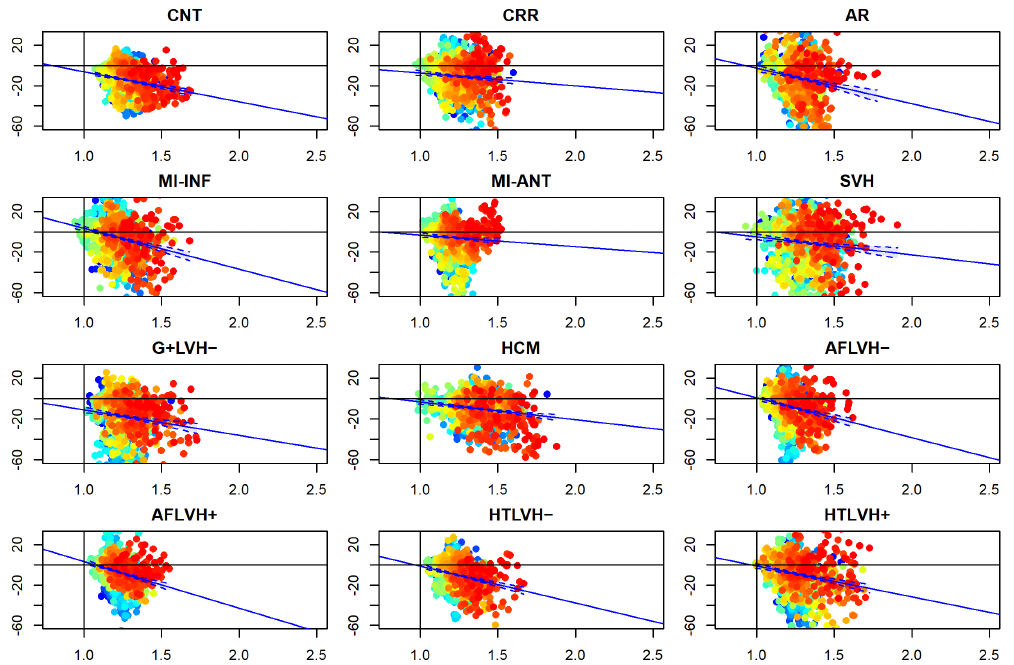
Figure 11. Relationship between Endo/Epi RMS static curvature ratio in diastole (in abscissa) and Endo-Epi α p differences (per category and per-landmark median values). Blue lines represent re- gression lines with confidence intervals. Points are colored according to their affiliation to “paral-